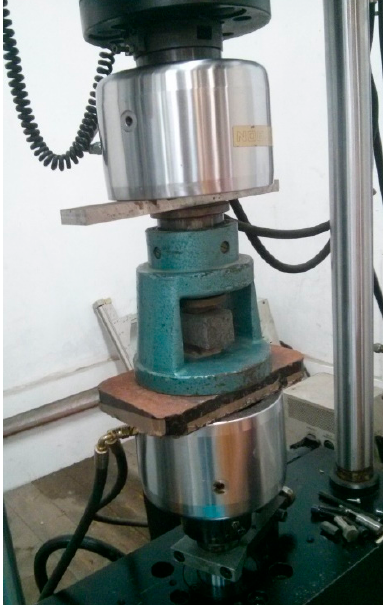
Figure 5. Mechanical tests, compressive strength.